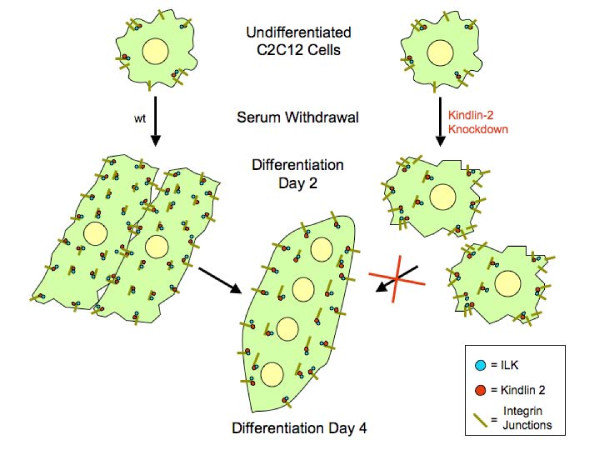
Schematic of kindlin-2 function during early myogenesis. A. Undifferentiated C2C12 cells with typical fibroblast-like morphology B. Upon change to differentiation media, control cells withdraw from the cell cycle and elongate. In cells with reduced levels of kindlin-2, cells fail to elongate, and instead maintain a "pro-migratory" phenotype. C. By differentiation day 4, elongated control cells fuse into multinucleated myotubes. Reduced levels of kindlin-2 result in failure of myotube formation, likely as a result of decreased elongation, inadequate cell adhesion and impaired myoblast fusion. One mechanism underlying these alterations is a failure of redistribution of ILK containing focal adhesions.